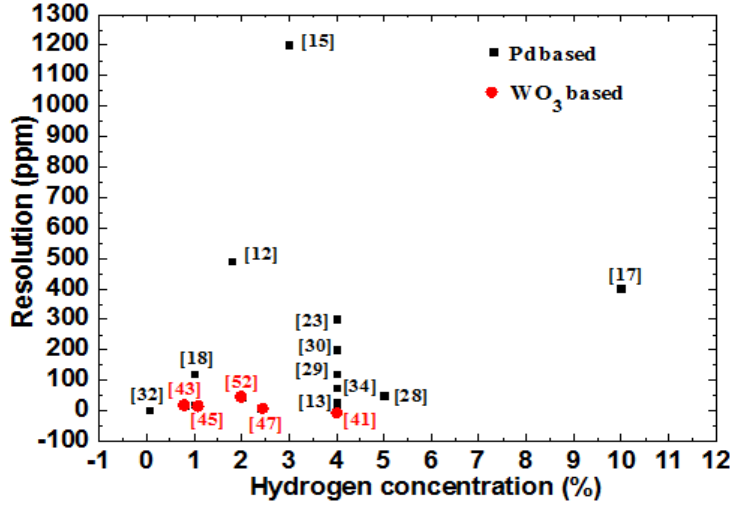
Figure 10. Comparison of the resolution of fiber grating hydrogen sensors based on Pd-based and WO 3 -based hydrogen sensitive materials .